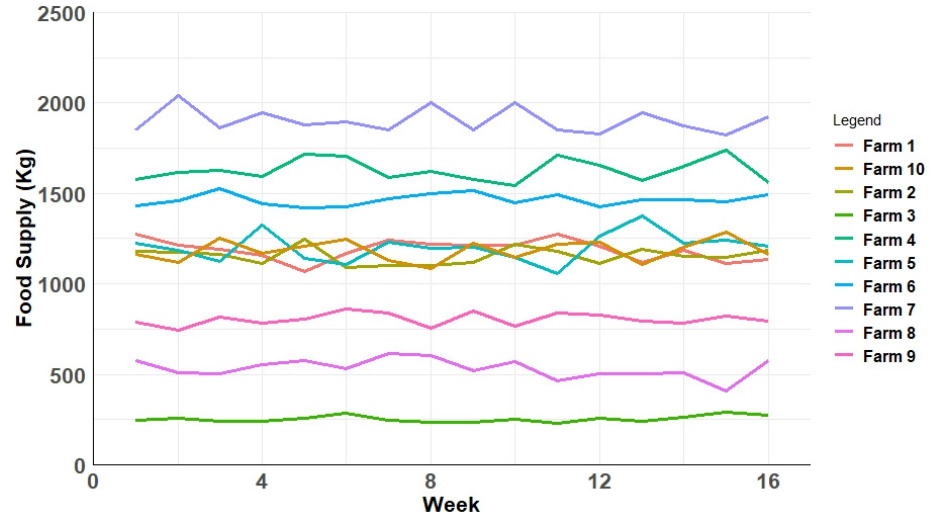
Figure 16. Food Supply at each Urban Farm due to Food Exchange.